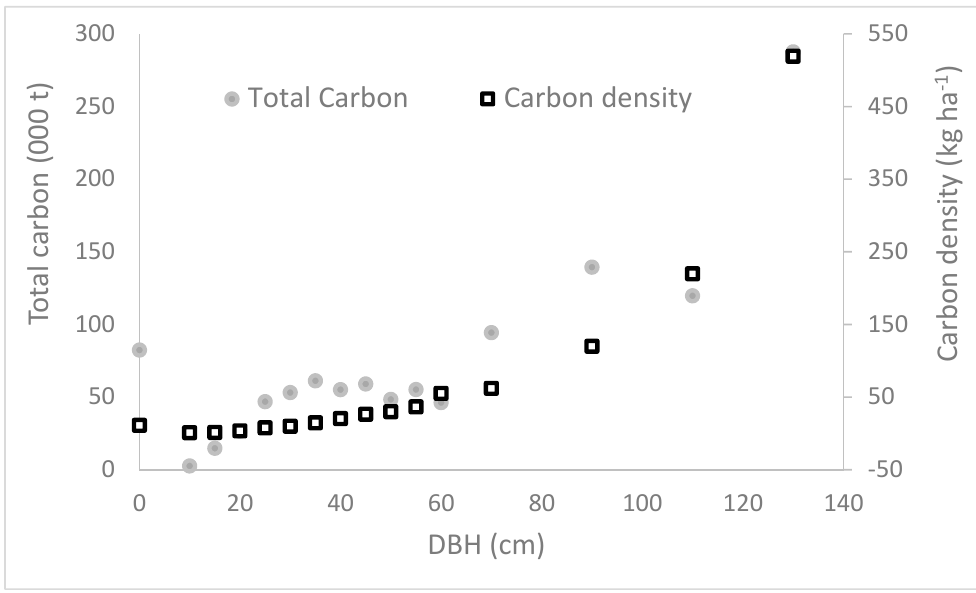
Figure 7. The total carbon stored and carbon stock densities for the different diameter classes in the urban forest of Kumasi.